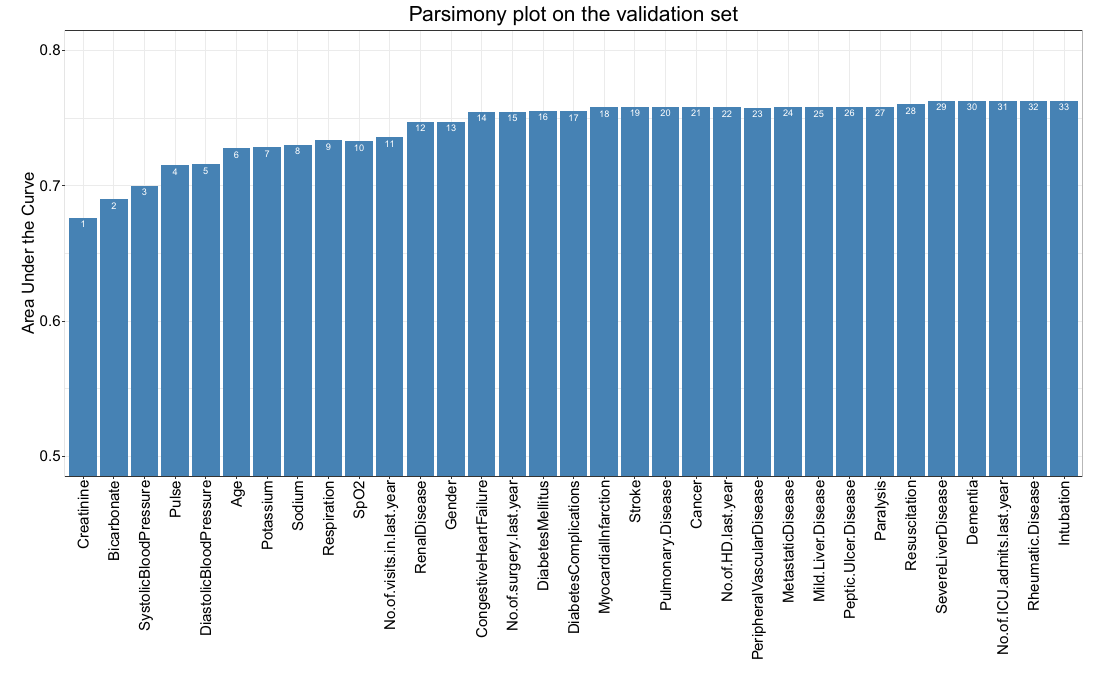
Figure 2. Parsimony plot of variables and predictive performance of model on the validation set. SpO 2 oxygen saturation.